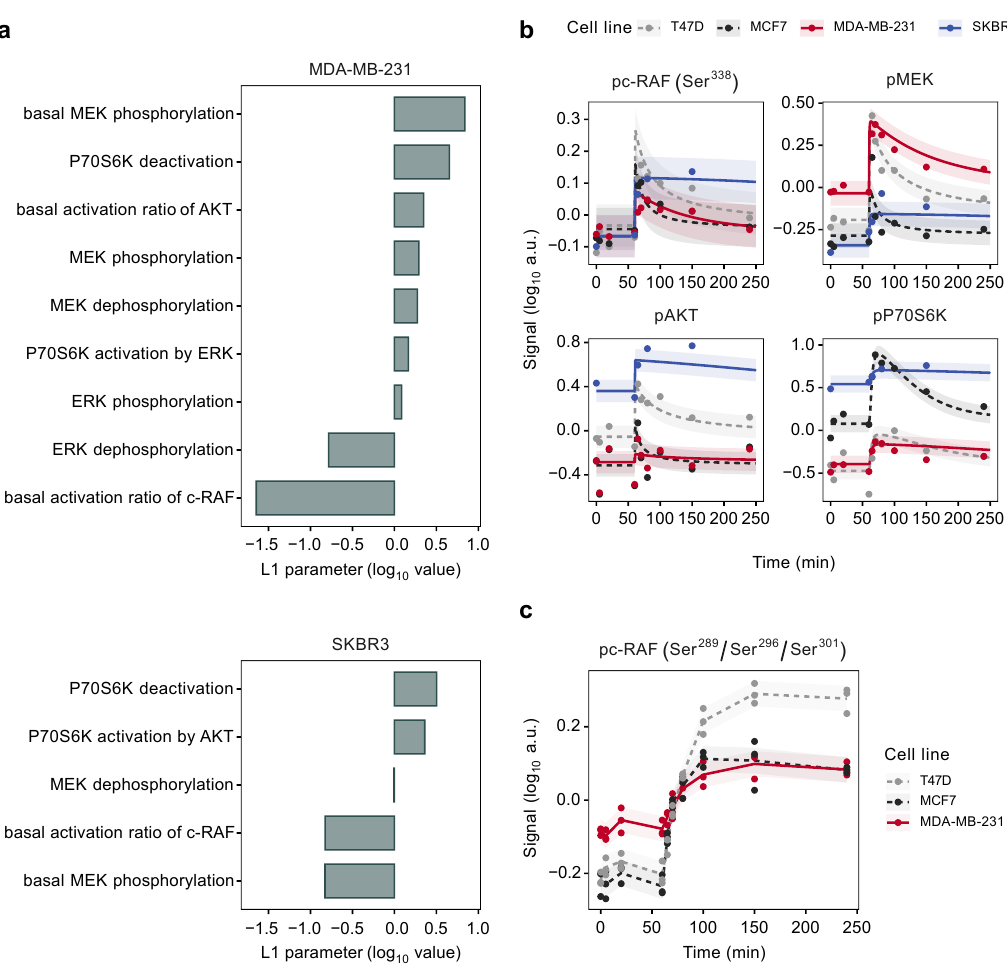
Figure 5. L 1 regularization identifies cell-line-specific parameters. ( a ) Regularization-dependent pa- ( r ) for the downstream module of MDA-MB-231 and SKBR3 cells. Positive rameter differences log i 10 values indicate elevated reaction rates relative to the luminal cell lines, while negative values show a decrease. AIC statistics were used to determine the optimal regularization strength for the analysis. ( b ) Model fits and experimental data (mean of 3 biological replicates) for the activating c-RAF, MEK, AKT and P70S6K sites in all four cell lines upon EGF stimulation. ( c ) Experimental testing of c-RAF phosphorylation (RPPA, n = 3) at positions Ser 289 /Ser 296 /Ser 301 , which are phosphorylated by ERK in a negative feedback mechanism to downregulate MAPK signaling